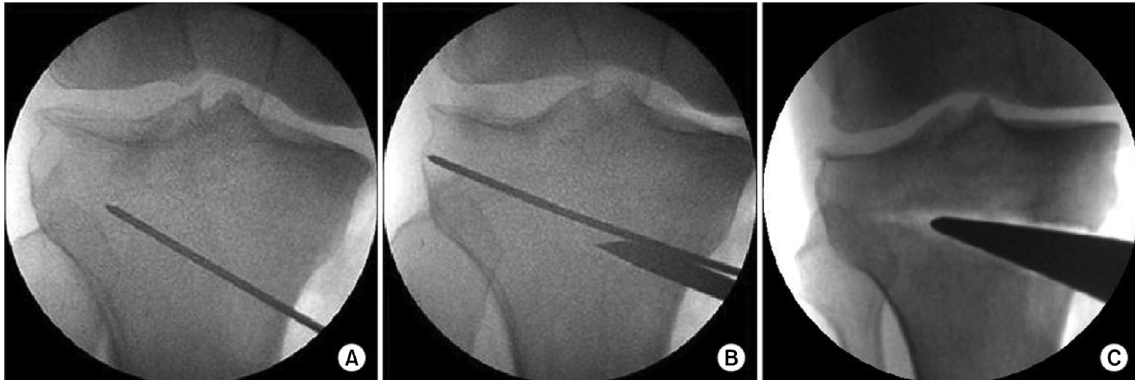
Figure 1. OWHTO. (A) Guide wire is placed, (B) osteotomy is done with a saw, (C) the medial tibia is released with a